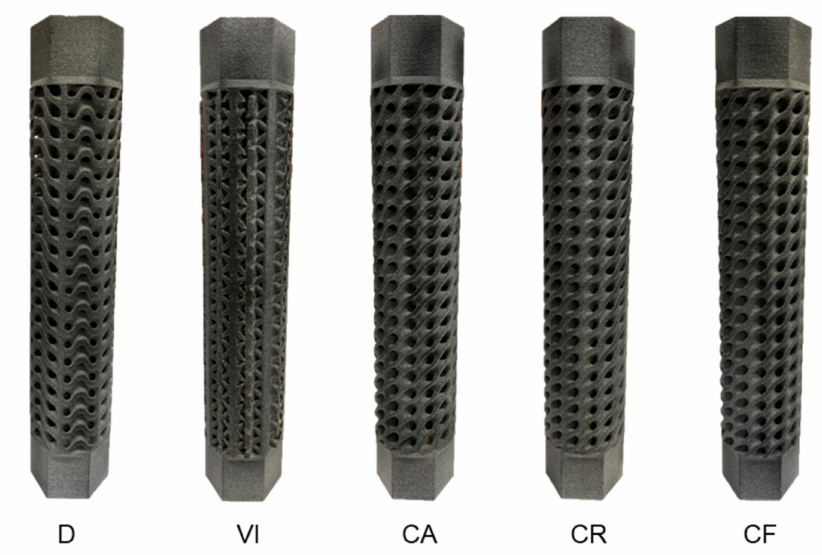
Figure 8. Additively manufactured samples of each lattice